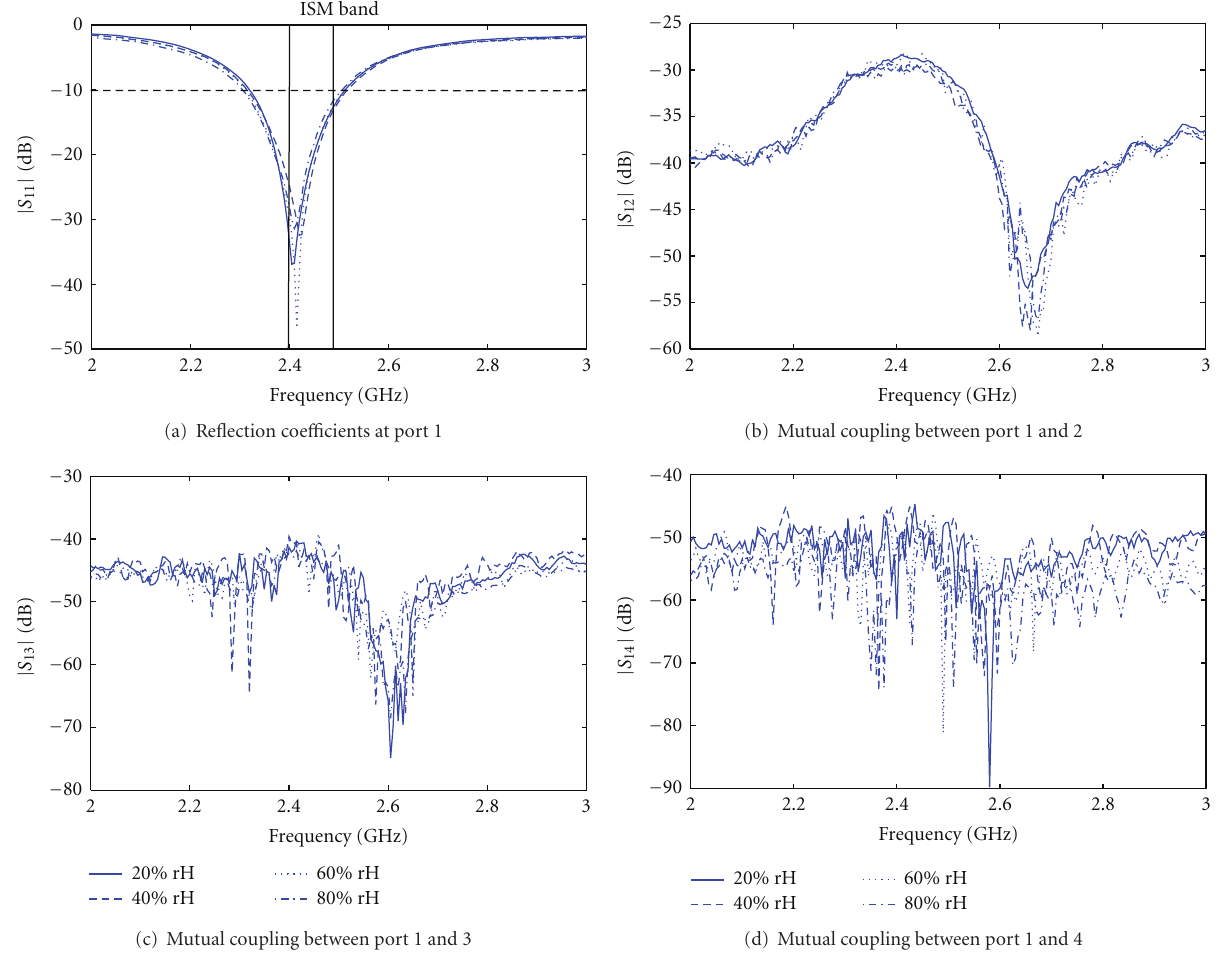
Figure 21: S-parameter measurements after acclimatization of the array, measured in a nonanechoic environment: reflection coe ffi cients at port 1 of the array and mutual coupling between port 1 of the array and the other three